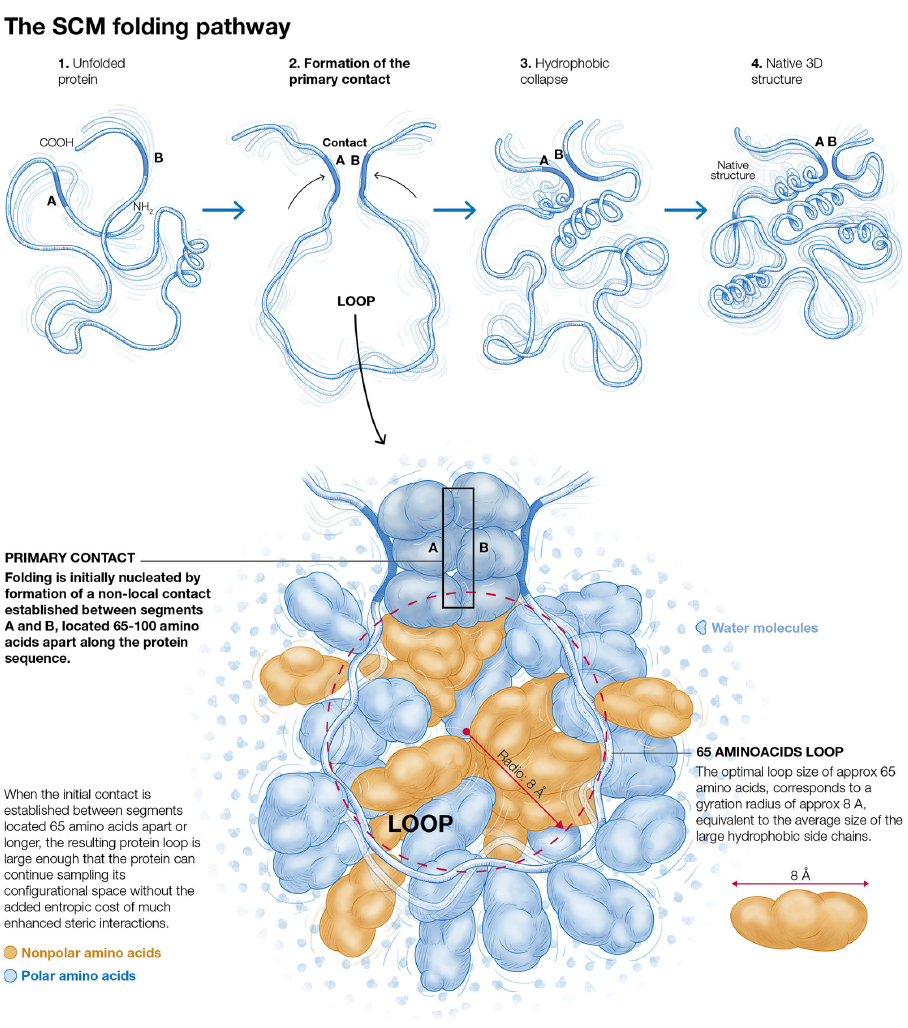
Figure 1. The physical basis for the formation of early non-local contacts in the SCM. The segments forming the contact are labeled A and